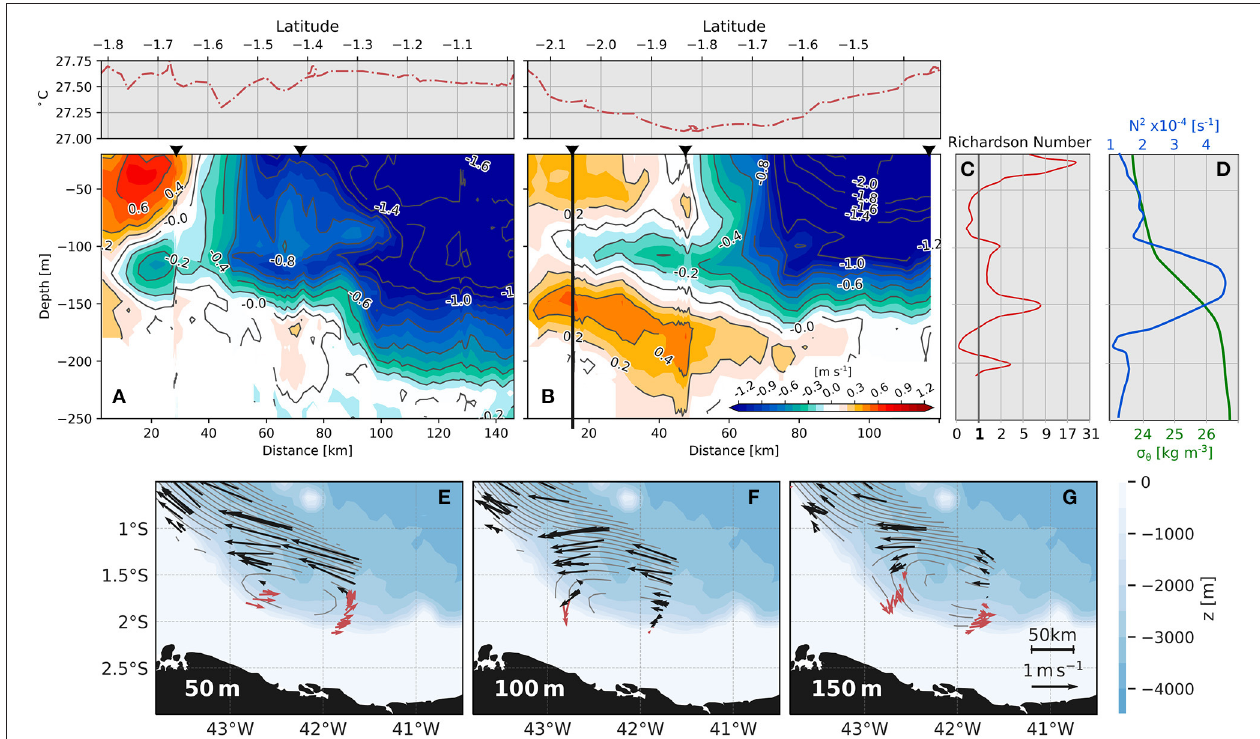
FIGURE 2 | ON1 transect A (A) and B (B) along-slope velocity section. Eastward velocities are positive. The ADCP temperature sensor data is shown in the upper panels (A,B) . The vertical straight line in panel B shows the location of the CTD cast used to estimate the Richardson number (C) and stratification (D) . The velocity field (vector plots) and its mapped stream function (contours obtained by Vectorial Objective Analysis) of the ADCP data from the ON1 cruise at 50 m (E) 100 m (F) and 150 m (G) . All plots are set to the same vector scale. Red arrows mark the flow related to the eddies. Each transect takes about half a day and hence they are